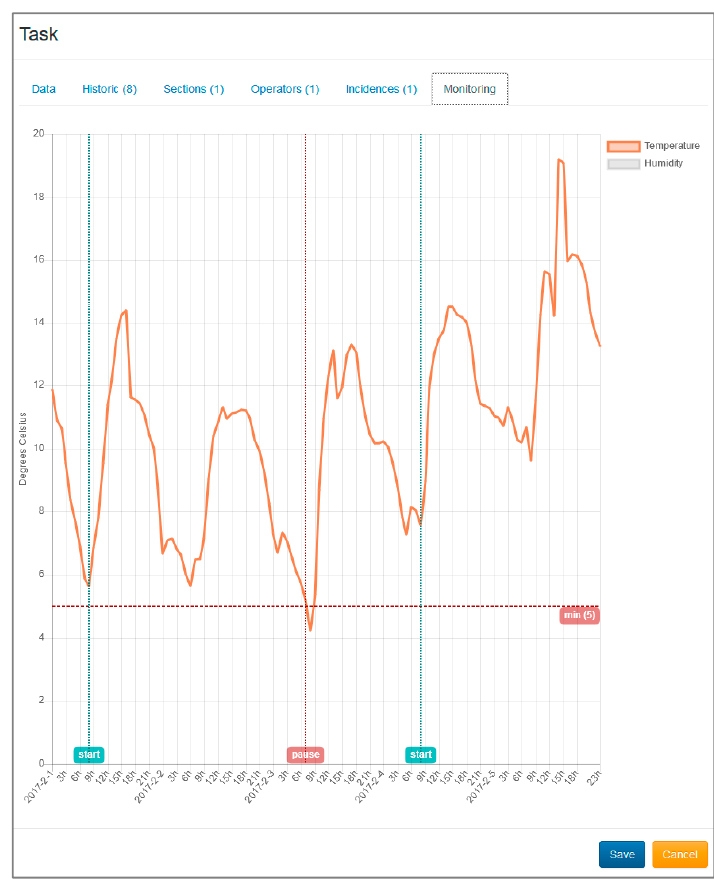
Figure 18. Screenshot from the LPS WebApp with the result of monitoring process.